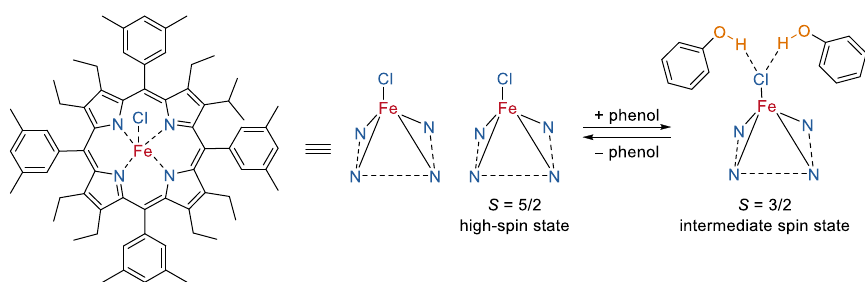
Figure 8. A spin-flip in Fe(III) porphyrin complexes responding to the presence of an H bonding partner [59].